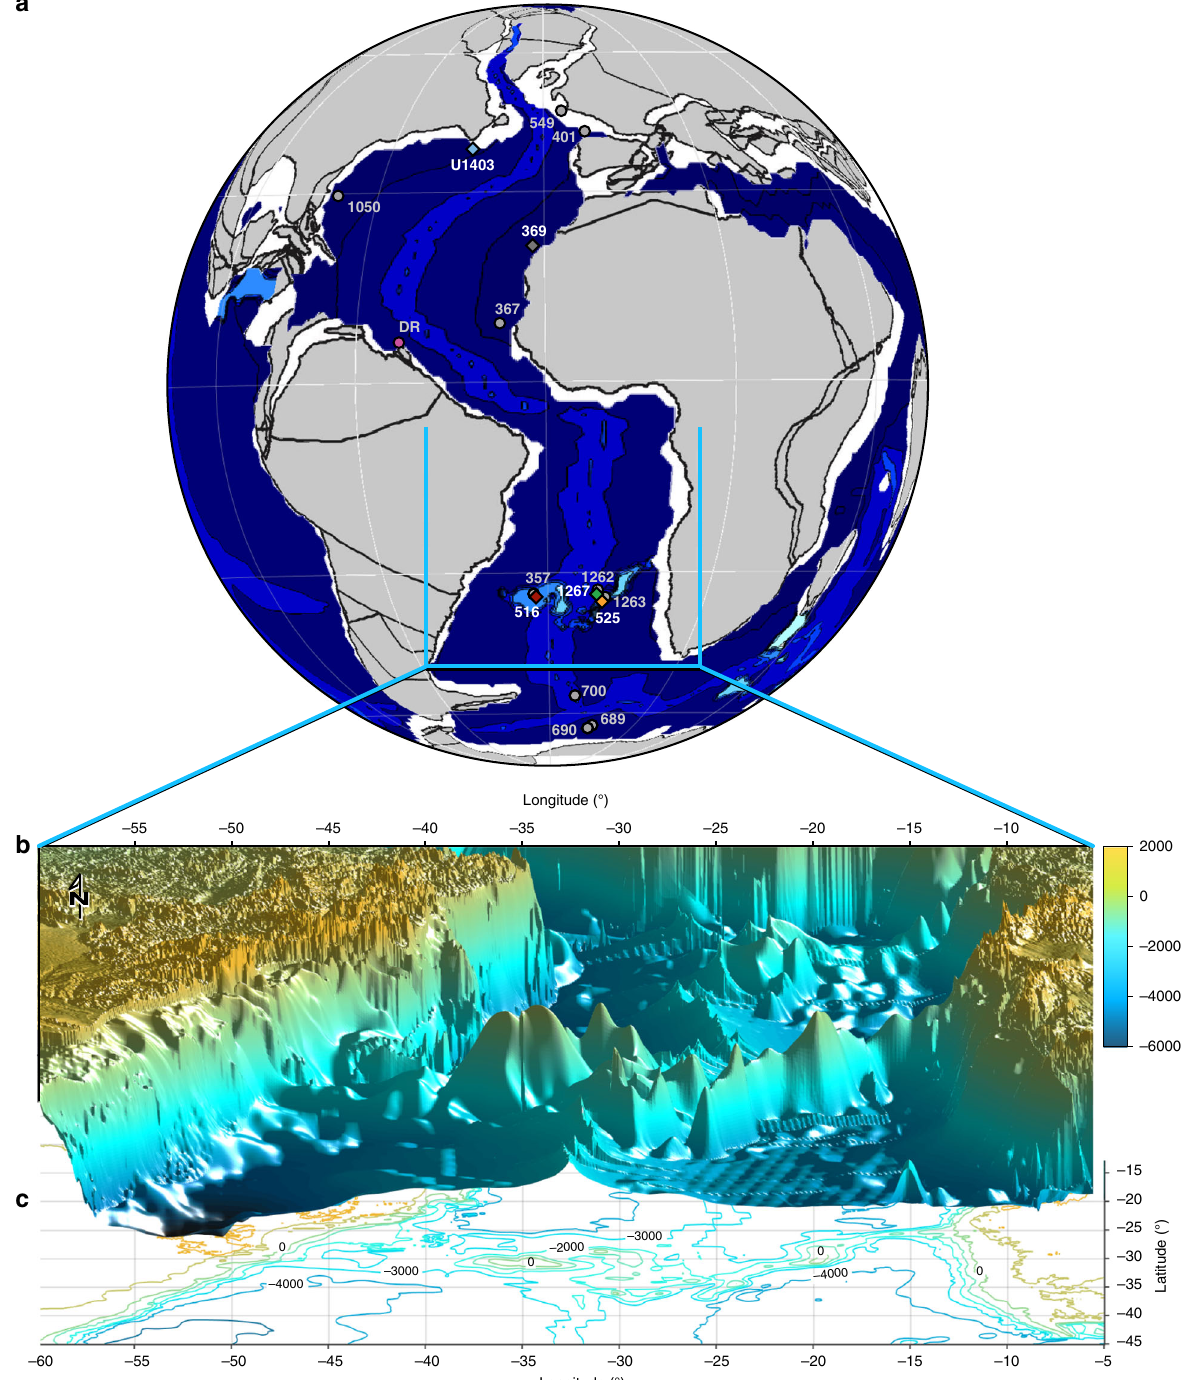
Fig. 2 Paleogeographic setting. a Paleogeographic reconstruction at 60 Ma. Plate tectonic con fi guration after ref. 63 and global bathymetry from ref. 39 . Circles indicate Atlantic Ocean drilling sites for which Nd-isotope data are available (at least four points in the time-interval 72 – 50 Ma), DR: Demerara Rise. Diamonds indicate locations for which new data are presented here. Numbers indicate DSDP/ODP/IODP Sites. b Three-dimensional plot of the reconstructed bathymetry of the South Atlantic with the Rio Grande Rise – Walvis Ridge barrier at 60 Ma from ref. 40 . c Contour plot of the bathymetry in panel B, with black numbers indicating depths in